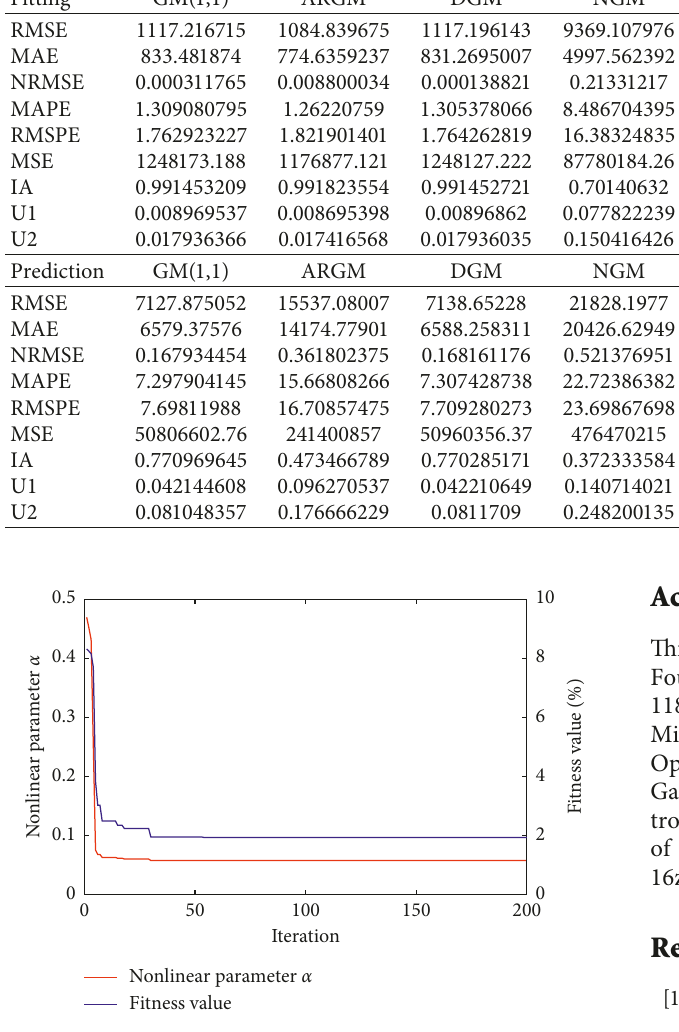
Table 15: Evaluation result of different grey models for fitting and forecasting China’s residential thermal energy consumption in Case 2. Fitting